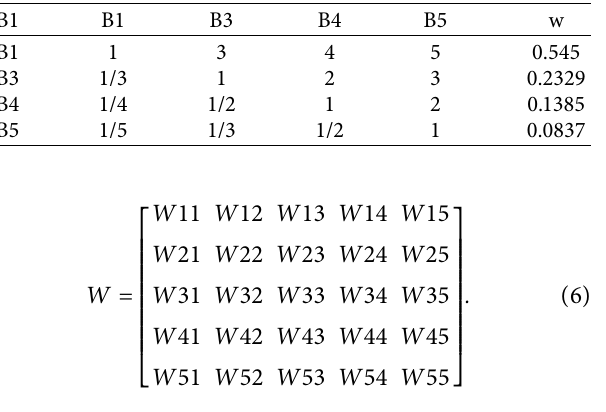
Figure 1: Network structure of the functional evaluation index Table 3: Judgment matrix a Table 4: Judgment matrix B.